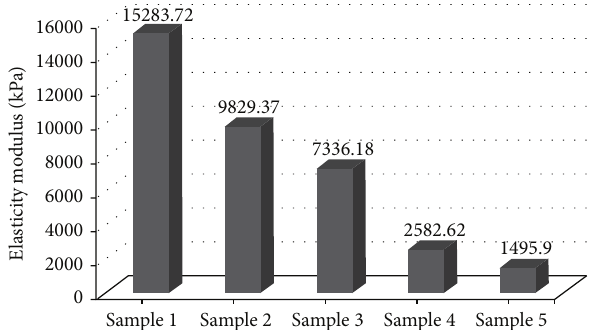
Figure 3: Distribution of elasticity modulus in samples one to five.